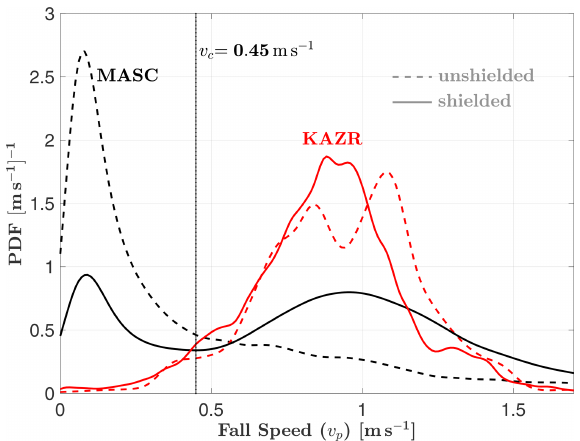
Figure 3. Comparison of fall speed v p probability density func- tion (PDF) estimates from MASC and KAZR measurements, both with and without wind shielding of the MASC. KAZR measure- ments are from the mean Doppler velocity below cloud base (pos- itive downward; see Sect. 2.1 for details). The cutoff fall speed v c marks the location of the local minimum separating the two modes of the shielded MASC distribution. Unshielded and shielded MASC observations are from two separate periods: 29 November